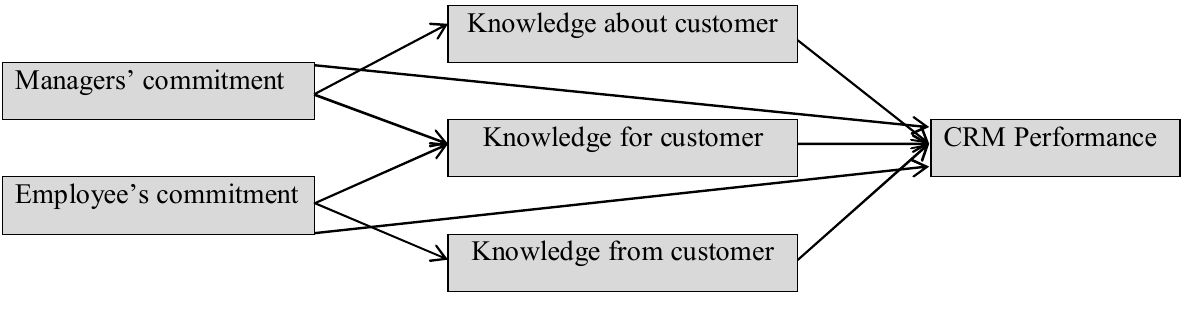
Fig. 1. The structure of the proposed